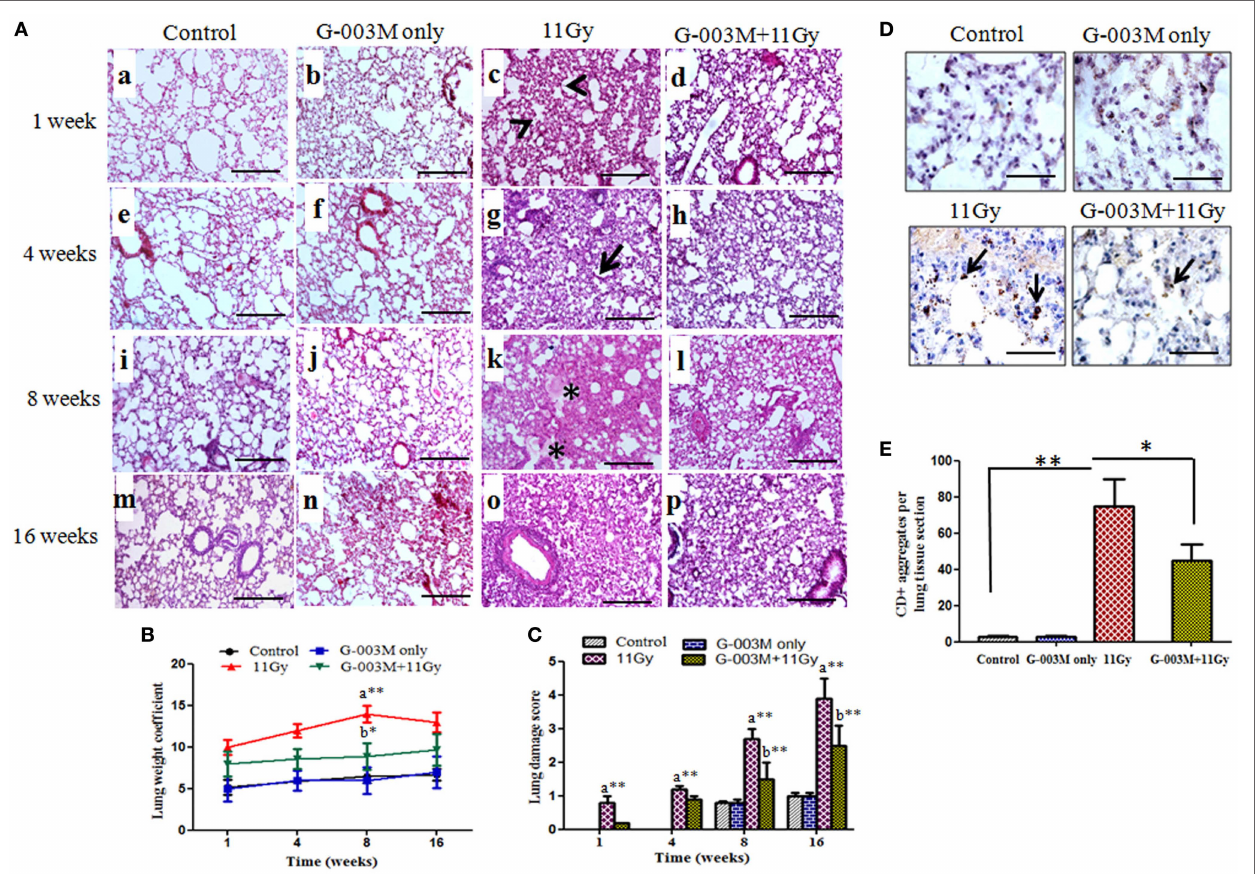
FigUre 6 | Effect of G-003M on lung inflammation and injury of 11 Gy thoracic-irradiated mice. (a) Representative light micrographs showing changes in lung histology at different time intervals. The alveoli in control group were normal on week 1 (a), 4 (e), 8 (i), and 16 (m). Irradiated lungs showing infiltration of inflammatory cells (c, arrow heads) and thickened alveolar septa (g, arrow) on 1 and 4 weeks. On week 8, alveolar edema (*) was visible and alveolar space was reduced by collagen deposition (k). Complete distortion of lung architecture and alveolar collapse on 16 weeks (o). In G-003M-pretreated groups inflammation, extent of lung damage and fibrosis was significantly less in comparison to irradiated groups on week 1 (d), 4 (h), 8 (l), and 16 (p). Lung sections were stained with hematoxylin and eosin and studied under light microscope (200 × ). Scale bar 100 µm. (B) Bar graph of lung weight coefficient from differentially treated groups. (c) Semiquantitative analysis of lung damage score. (D) Immunohistochemical staining of CD45 + leukocytes in lung of differentially treated mice at 4 weeks after treatment (1,000 × ). Representative photomicrograph from irradiated lungs shows intense CD45 + aggregates (arrows), indicating infiltration of inflammatory cells. G-003M-pretreated group representing less number of CD45 + cell aggregates in comparison to irradiated group. Control and G-003M only groups showing very few CD45 + cells in lung sections. Scale bar 10 µm. (e) Quantification of lung CD45 + inflammatory aggregates per section (10 fields) of individual mice identified by IHC staining. Data are represented as means ± SEM from six mice for each group. a = 11 Gy vs. controls, b = G-003M + 11 Gy vs. 11 Gy. * p < 0.05; ** p <